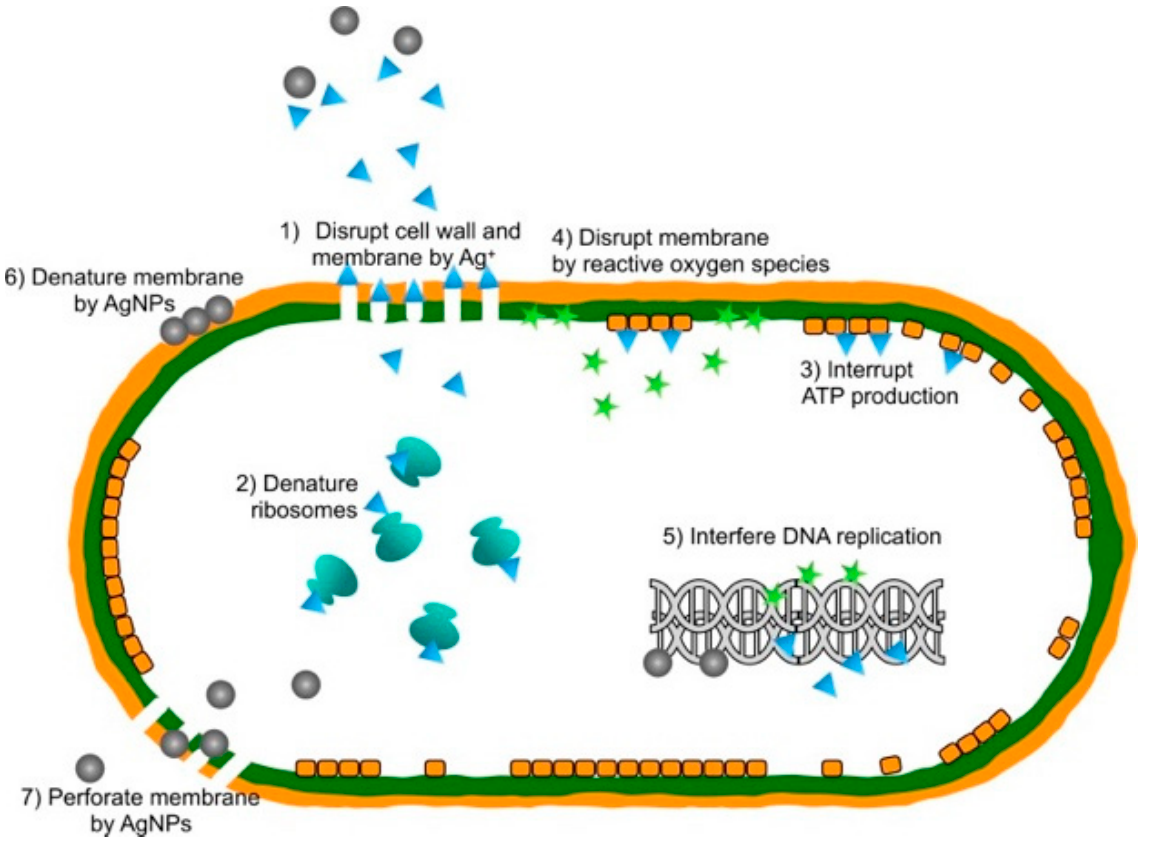
Figure 1. The antibacterial actions of silver nanoparticles (AgNPs). (1) Disruption of the cell wall and cytoplasmic membrane: silver ions (Ag + ) released from silver nanoparticles adhere to or pass through the cell wall and cytoplasmic membrane. (2) Denaturation of ribosomes: silver ions denature ribosomes and inhibit protein synthesis. (3) Interruption of adenosine triphosphate (ATP) production is terminated because silver ions deactivate respiratory enzymes on the cytoplasmic membrane. (4) Membrane disruption by reactive oxygen species: reactive oxygen species produced by the broken electron transport chain can cause membrane disruption. (5) Interference of deoxyribonucleic acid (DNA) replication: silver and reactive oxygen species bind to deoxyribonucleic acid and prevent replication and cell multiplication. (6) Denaturation of membrane: silver nanoparticles accumulate in the cell wall pits and cause membrane denaturation. (7) Perforation of membrane: silver nanoparticles directly move across the cytoplasmic membrane, which can release organelles from the cell. Reprinted with permission from [14]. Originally published by and used with permission from Dove Medical Press Ltd. Copyright remains with the author and Dove Medical Press Limited, no transfer of copyright is inferred or